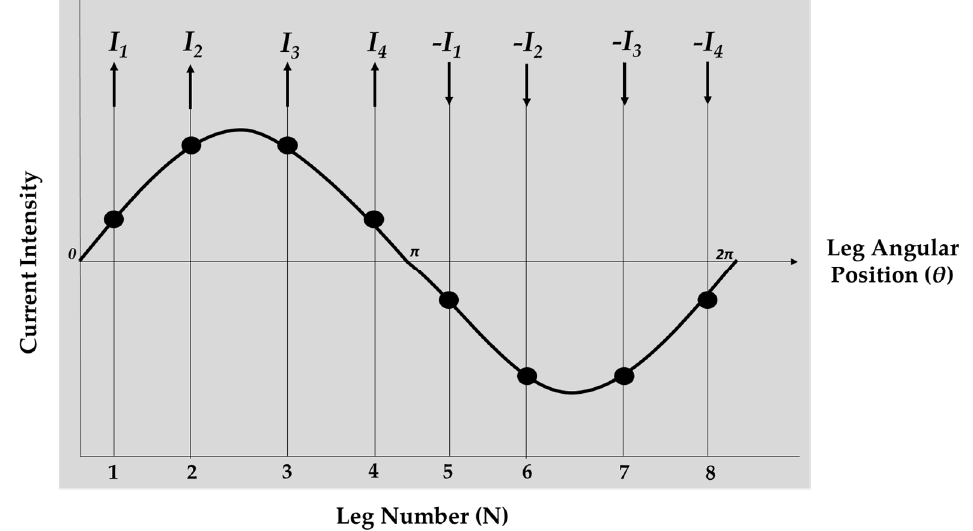
Figure 3. Sinusoidal legs currents distribution on an 8-legs birdcage coil in dominant resonance mode.